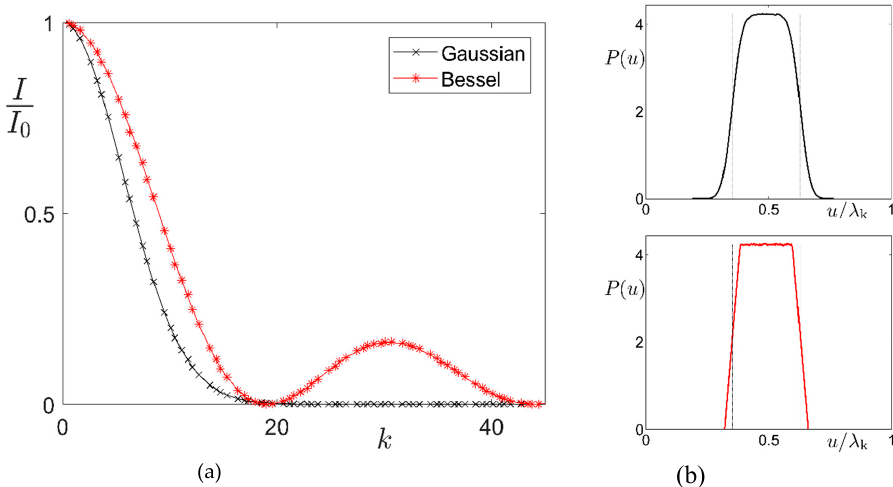
Figure 1. ( a ) Envelopes of the diffraction peaks’ intensities for the Fibonacci chain (one-dimensional quasicrystal) with phonons, I , calculated vs. intensities for perfect Fibonacci chain without phonons, I 0 . This is obtained by two different shapes of atomic distributions around ideal positions: Gaussian (black crosses) and Bessel function (red stars). Generally, the set of peaks is infinitely dense and its arrangement is aperiodic. For clarity, only peaks with limited indices and intensities are shown. Intensities are calculated within the statistical method as the squares of the Fourier transform of the corresponding distribution function P ( u ). ( b ) The corresponding probability distributions AUC are given by Gaussian (black) and harmonic (red) distributions. For ideal positions (no phonons), the uniform probability distribution P ( u ) is observed (marked with dashed